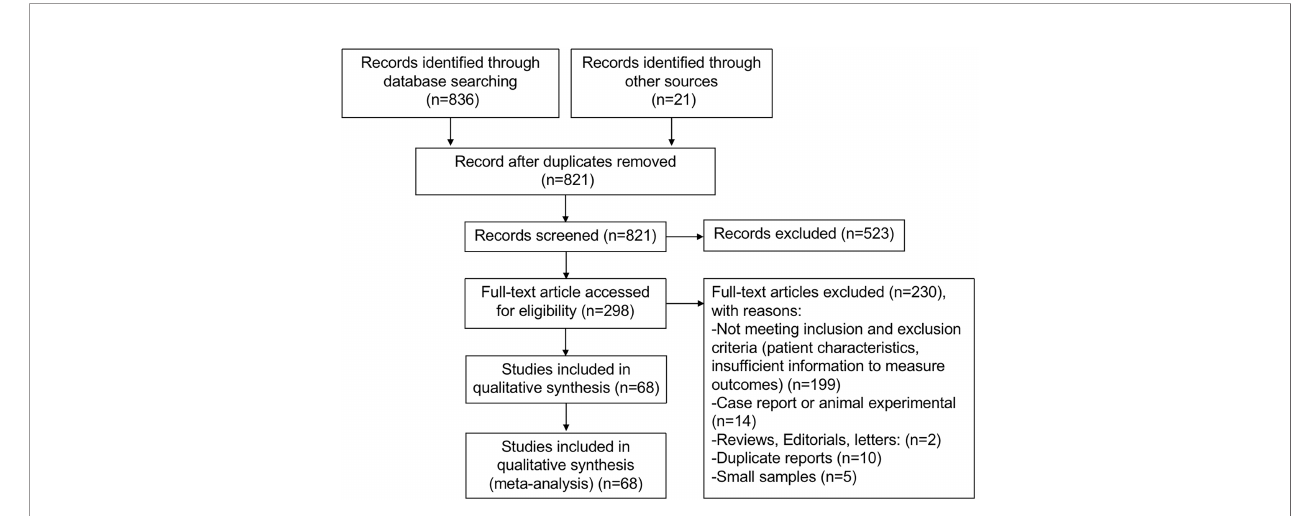
FIGURE 1 | Flow diagram depicting the process of conducting